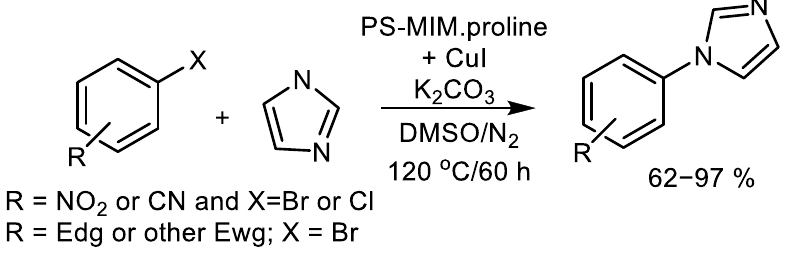
Scheme 28. Arylation of imidazole catalyzed by CuI/PS-MIM.proline [104].